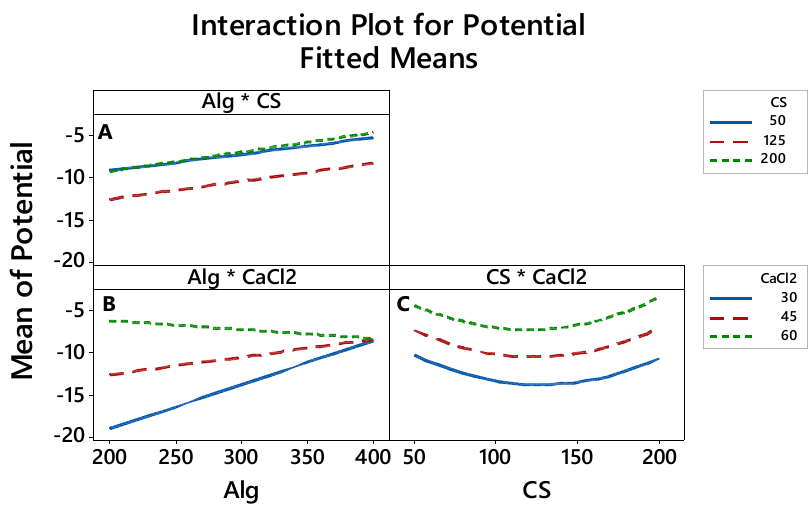
Figure 8. Interaction effects of factors on the zeta potential.